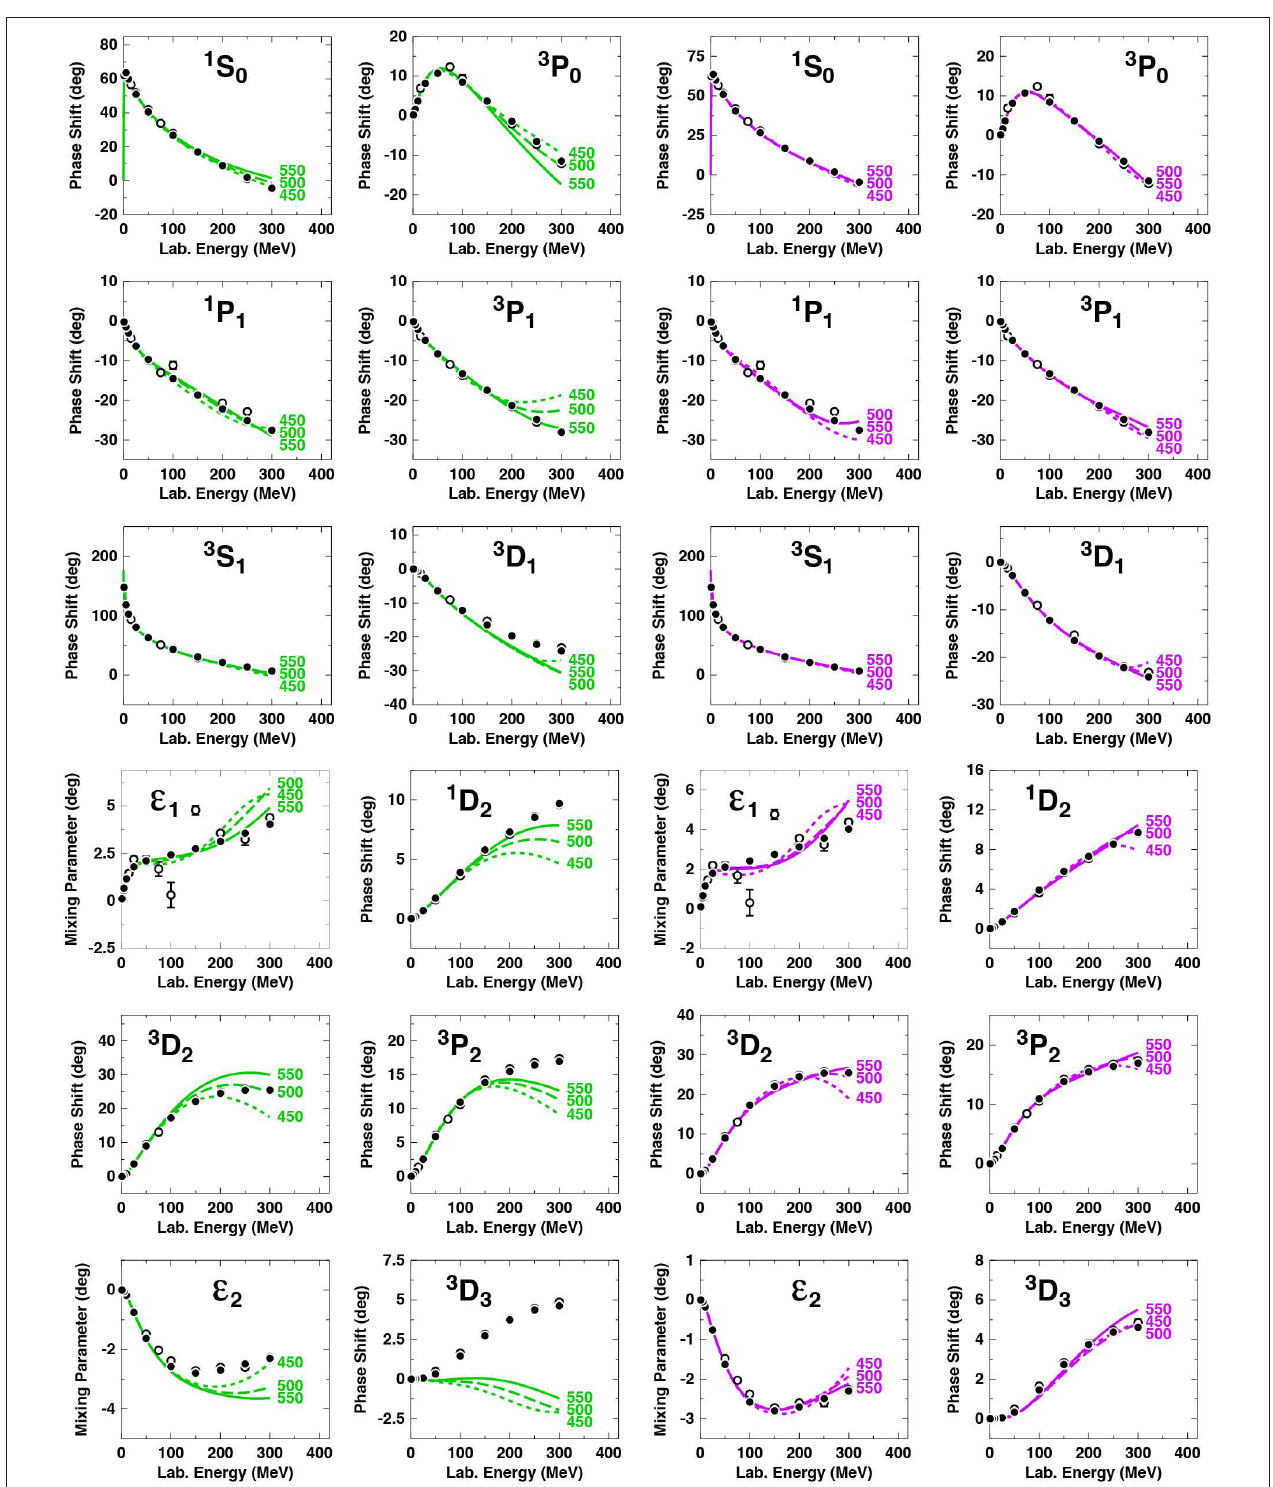
FIGURE 16 | Cutoff variations of the np phase shifts at NNLO (left side, green lines) and N 4 LO (right side, purple lines). Dotted, dashed, and solid lines represent the results obtained with cutoff parameter 3 450, 500, and 550 MeV, respectively, as also indicated by the curve labels. Note that, at N 4 LO, the cases 500 and 550 = MeV cannot be distinguished on the scale of the figures for most partial waves. Filled and open circles as in Figure 15 . Reprinted figure with permission from Entem et al. [37], copyright (2017) by the American Physical